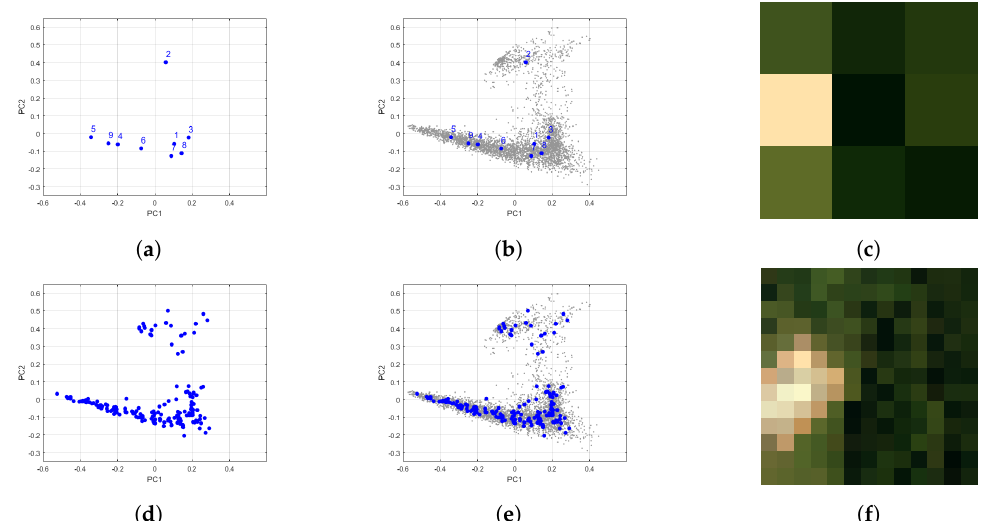
Figure 8. Visualizing superpixel representations in the data cloud: ( a ) superpixel means scatter plot for region size = 25 × 25; ( b ) overlaying of superpixel means on the full-image scatter plot; ( c ) true-color composite for the SP image; ( d ) superpixel means scatter plot for region size = 5 × 5; ( e ) overlaying of superpixel means in the full-image scatter plot; ( f ) true-color composite for the SP image.